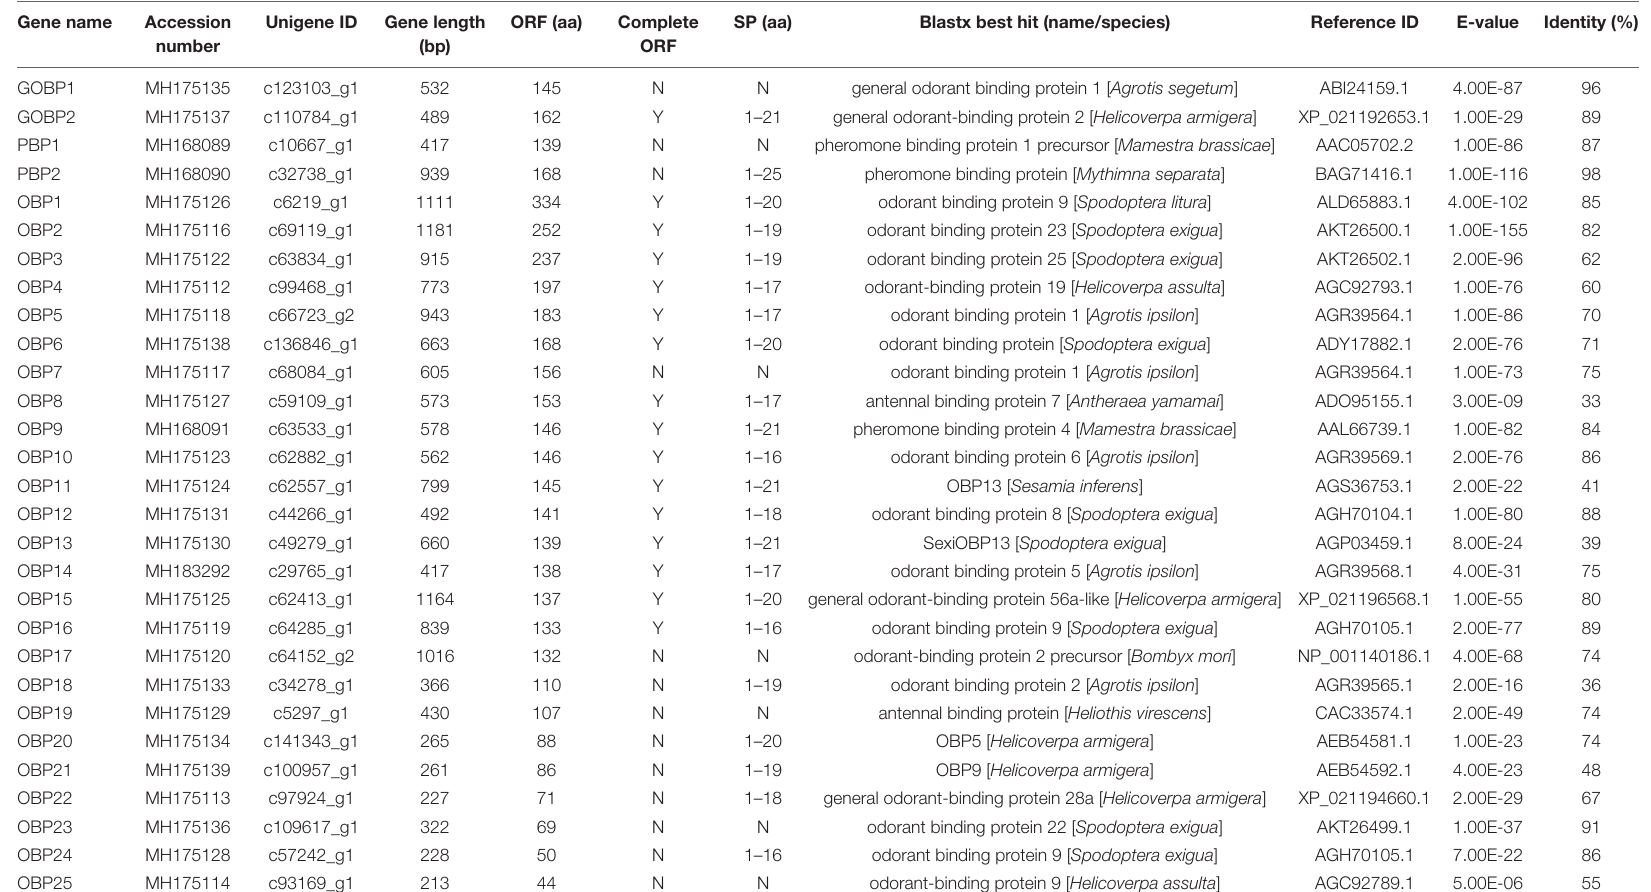
TABLE 1 | Odorant-binding proteins identified in Mythimna separata brain